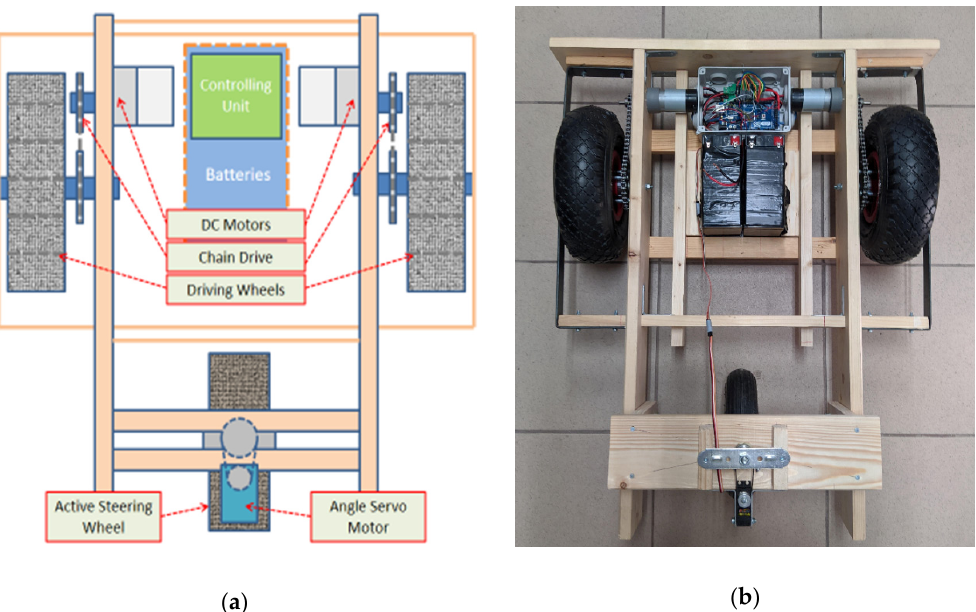
Figure 2. The basic electromechanical layout of the harvester-assisting vehicle: ( a ) Initial design; ( b ) Implementation outcome.